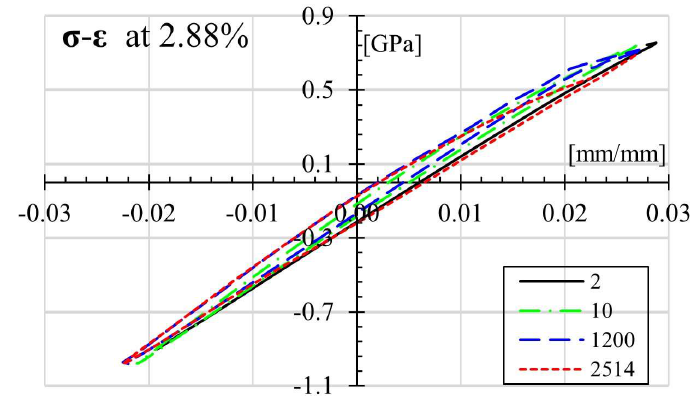
Figure 8. Exemplary result for the hysteresis loops at ±2.88% ε .